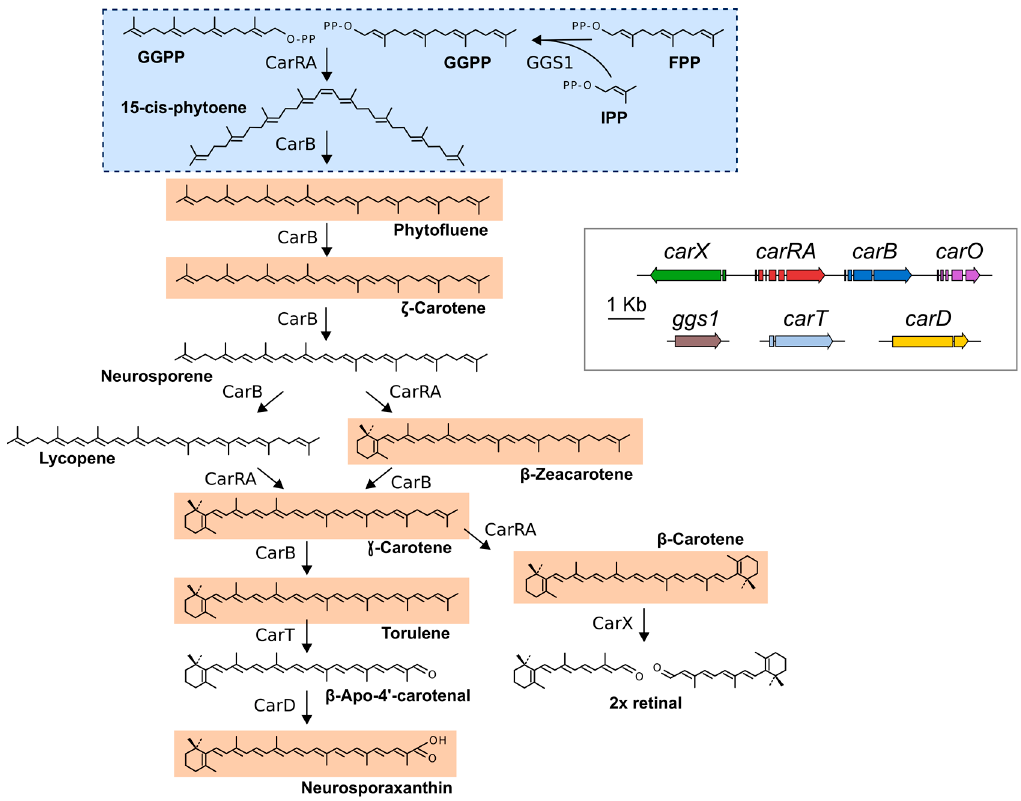
Figure 1. Carotenoid biosynthesis in Fusarium . Gene products responsible for the biosynthetic steps are indicated close to each arrow. Genomic organization of the genes is shown in the inserted box. Carotenoids detected in the High Performance Liquid Chromatography (HPLC) analyses described in Figure 4 are shaded in orange. Compounds shaded in blue (dotted box) are not detected in the chromatograms because of lack of absorption in the covered detection range (350–600 nm).